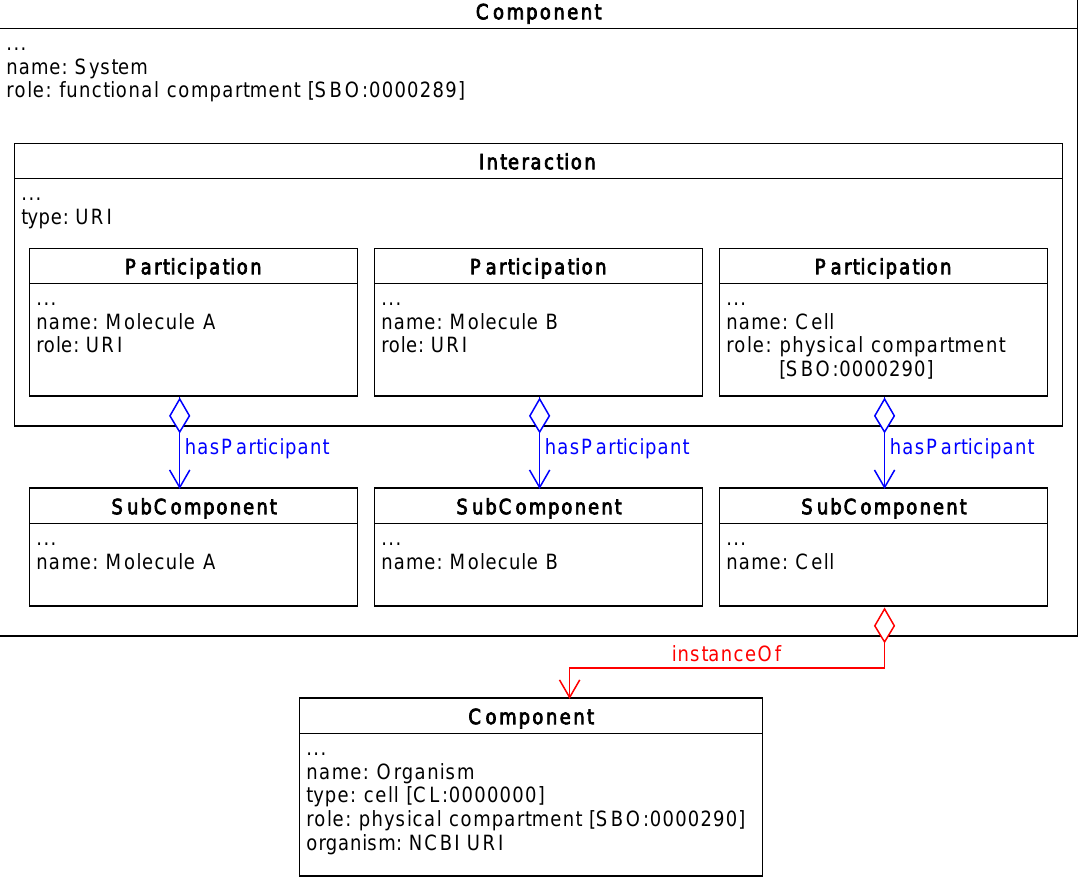
Figure 22: This is a proposed approach for capturing cell designs in SBOL. A Component annotated with a IRI pointing to an entry in the NCBI Taxonomy Database is used to capture information about the cell’s strain/species. The Component has a type of “Cell” from the Gene Ontology (GO), and a role of “physical compartment”. Another Component is used to represent a system in which the cell is implemented. Entities, including the cell, are instantiated as Feature s, and processes are captured using the Interaction class. Processes that are contained within the cell are represented by including the cell as a participant with a role of “physical